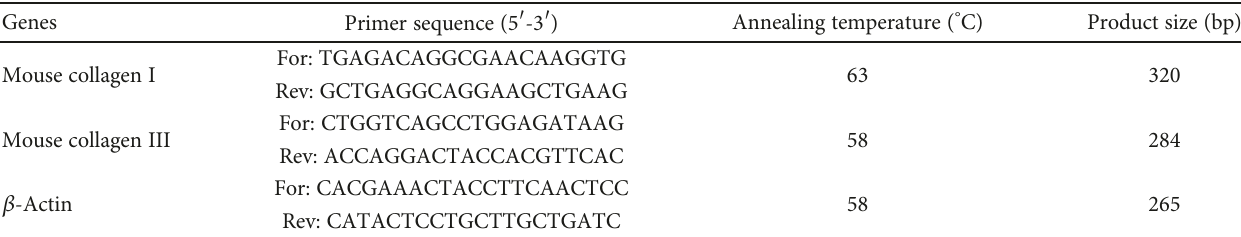
Table 1: Primers for real-time